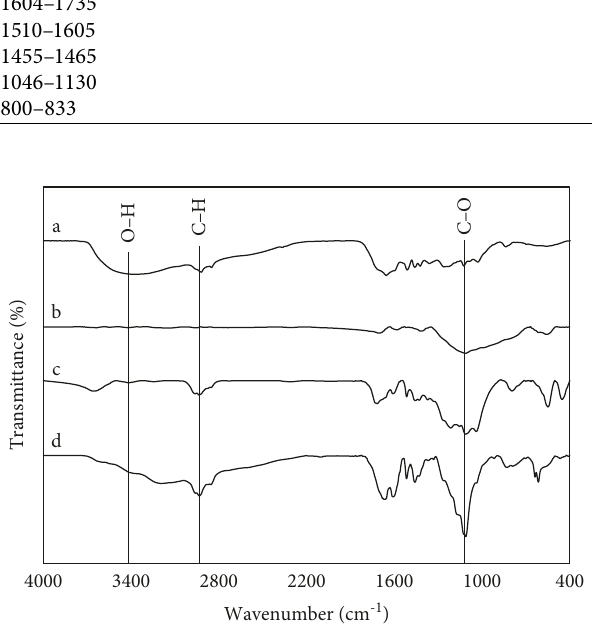
Figure 5: FTIR spectra of rice straw lignin (a) and LP from the lignin depolymerization under the ethanol concentration of (b) water, (c) 50%, and (d) 100% at 275 ° C, 30min, 75:1 (mL ethanol:1g lignin).